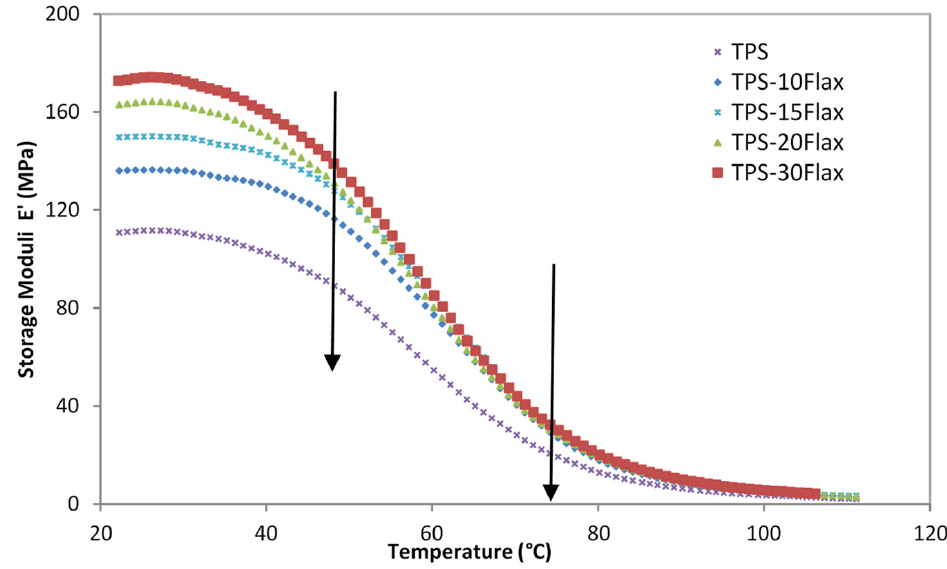
Figure 12. Evolution of the storage modulus E ′ for TPS and TPS/(% percentage) shives of flax as a function of temperature.